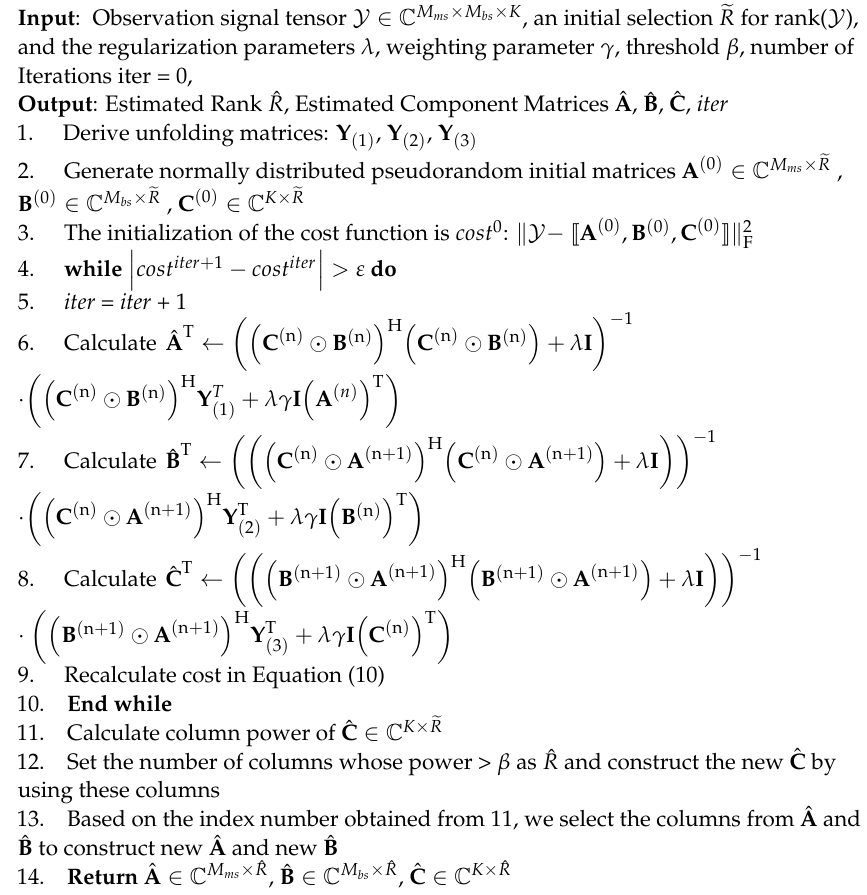
Algorithm 1. The Proposed Joint CP Tensor Decomposition-Based Estimation